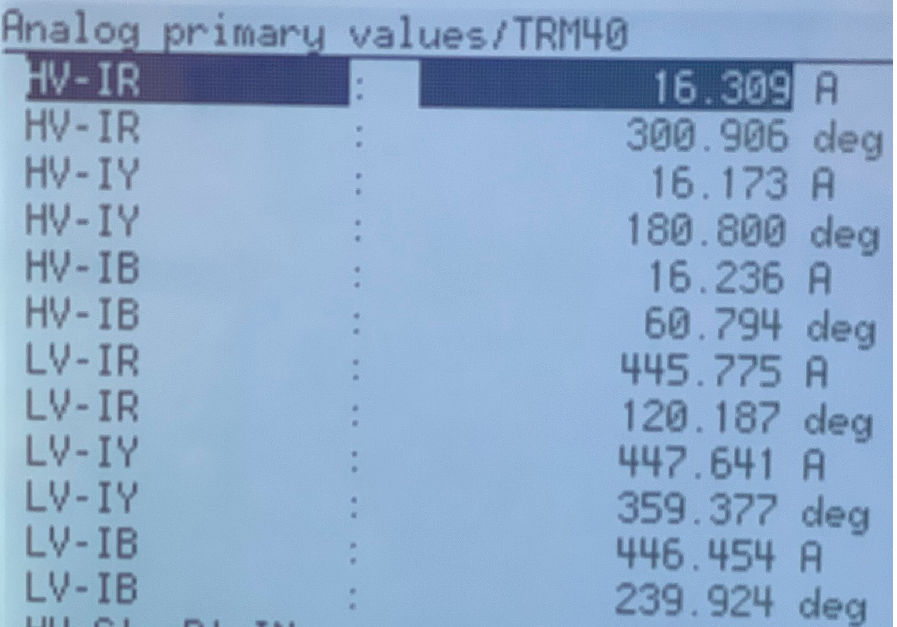
Figure 5. Measured values for HV and LV currents by the relay RET670 display unit [16]. Here, HV-IR, HV-IY, and HV-IB are the HV-side current measurements, and LV-IR,